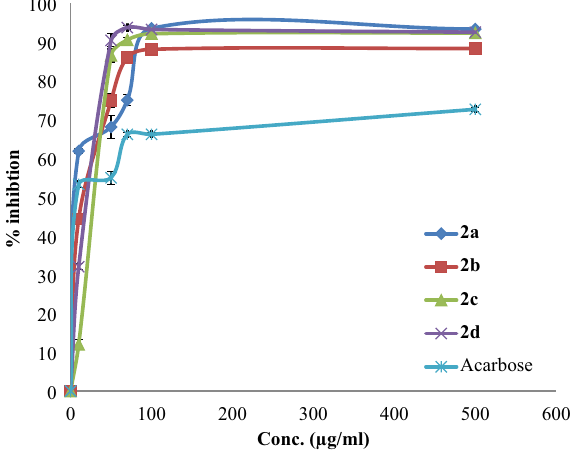
Figure 3. % Inhibition of α-amylase by the tested